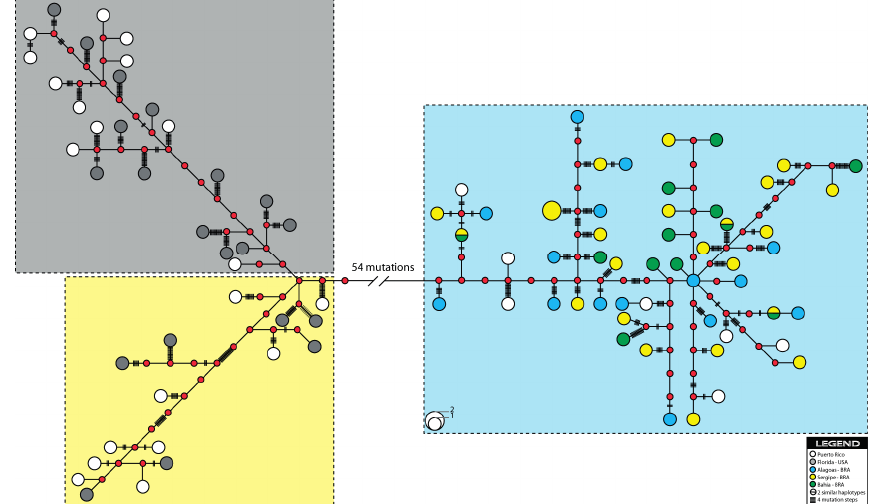
Figure 3. Median-joining network constructed for the C. guanhumi haplotypes in the Western Central Atlantic. Each circle represents one unique haplotype, with the area being proportional to the frequency of the haplotype in the five populations. Each haplotype is coloured according to the legend. Red circles indicate missing intermediate haplotypes that were not found in the analyzed individuals. Vertical bars on the line indicate the number of substitutions separating two haplotypes. A lack of vertical bars on the line connecting haplotypes indicates that a single substitution separates the two